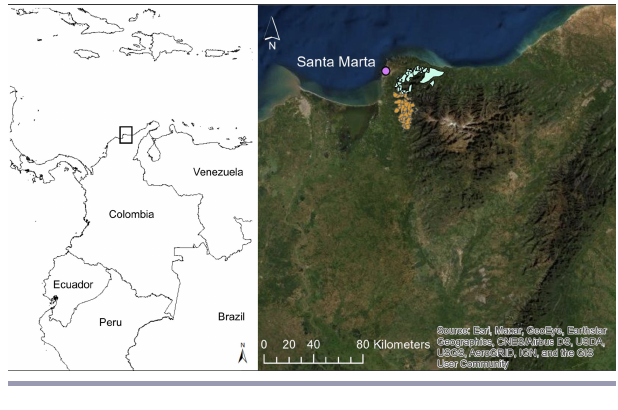
Fig. 1 . Site map showing the study region in Colombia, South America (L) and the full extent of the Sierra Nevada de Santa Marta, Colombia, and the location of the studied coffee growing regions (R). The teal is the Santa Marta coffee growing region and the orange is the Ciénaga coffee growing region where focus groups were conducted. The city of Santa Marta is denoted by a purple dot.